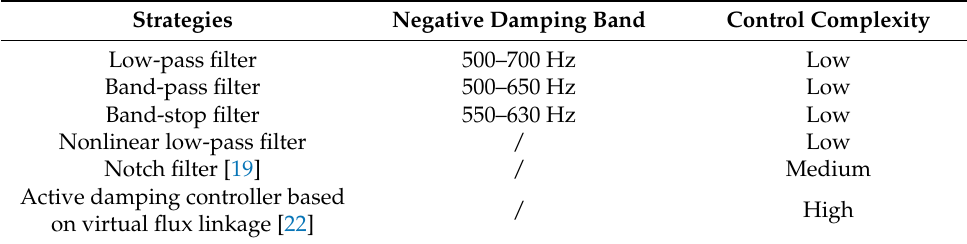
Table 2. Comparison of oscillation suppression ability of different control strategies.